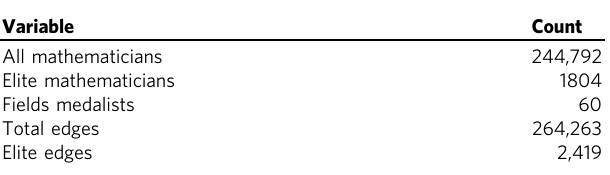
Table 1 Summary statistics of the Mathematics Genealogy Project data